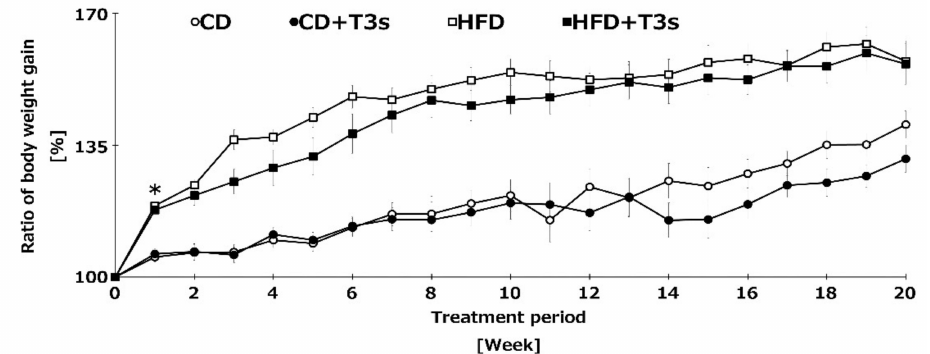
Figure 2. Changes in the ratio of body weight gain of all treatment groups. Body weight was measured once per week for 5 consecutive months. Body weight before feeding of each diet was set to 100%. CD = Control diet ( n = 10), CD + T3s = CD + T3- \ mix ( n = 10), HFD = high-fat diet ( n = 10). HFD + T3s = high-fat diet + T3 mix ( n = 10). Data are expressed as mean ± SE, and the timeline shows treatment period. Tukey–Kramer’s method: * p < 0.05 treatment period of HFD vs. previous week of HFD.